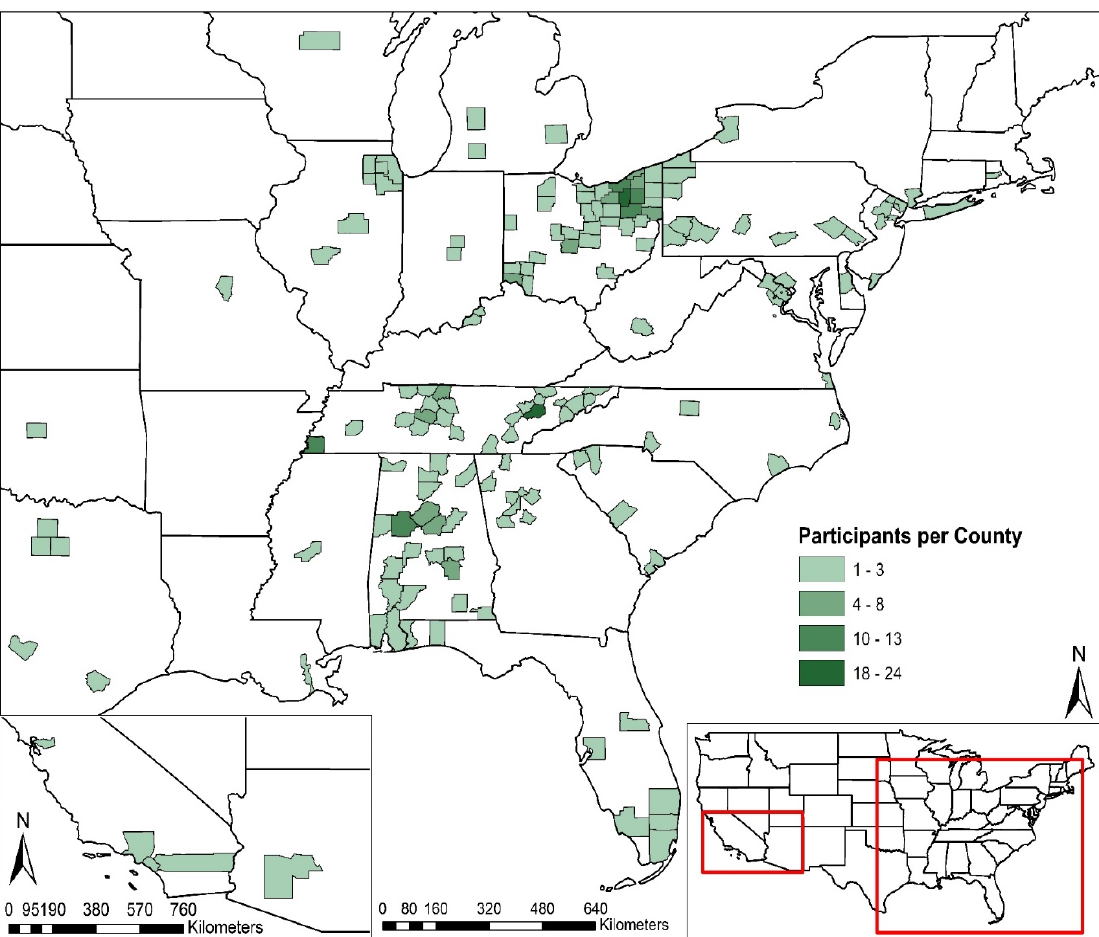
Figure 1. Number of participants in each county.